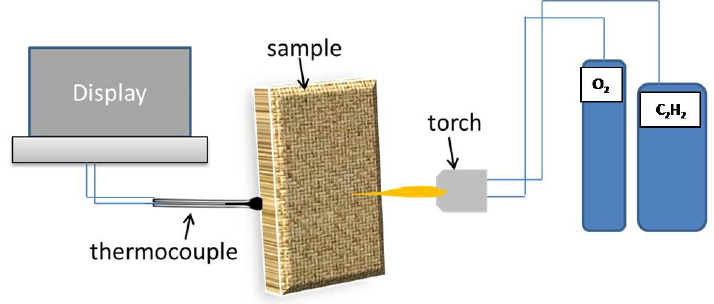
Figure 3. Oxyacetylene torch apparatus used to perform ablation tests.